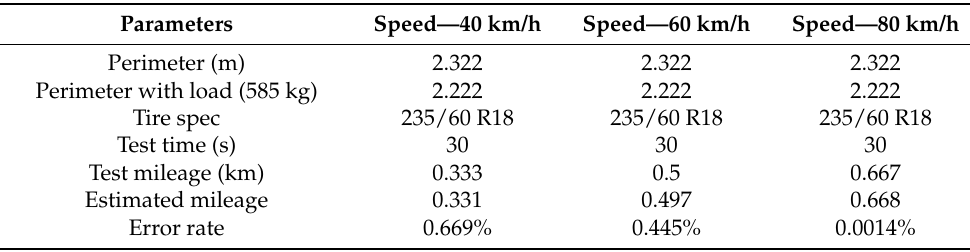
Table 1. Mileage comparison